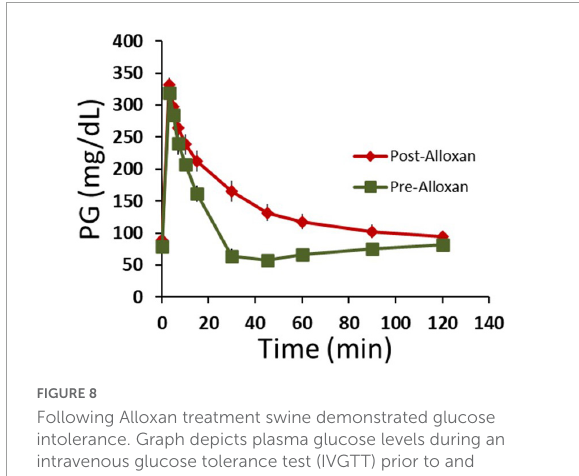
FIGURE8 Following Alloxan treatment swine demonstrated glucose intolerance. Graph depicts plasma glucose levels during an intravenous glucose tolerance test (IVGTT) prior to and following the administration of Alloxan to the swine. n = 6 swine. Error bars are SEM.